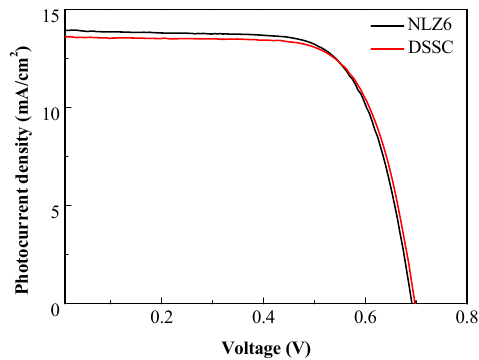
Fig. 10 Current–voltage ( I – V ) characteristics of DSSC without and with upconversion luminescence material